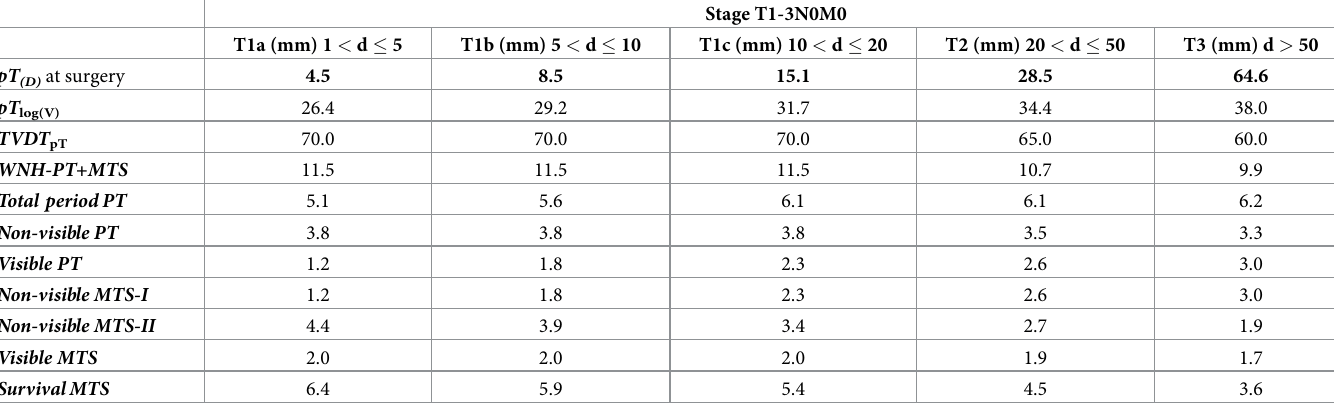
Table 2. The critical periods of PT and secondary distant MTS growth of BC for different stages (pT1-4N0M0), according to